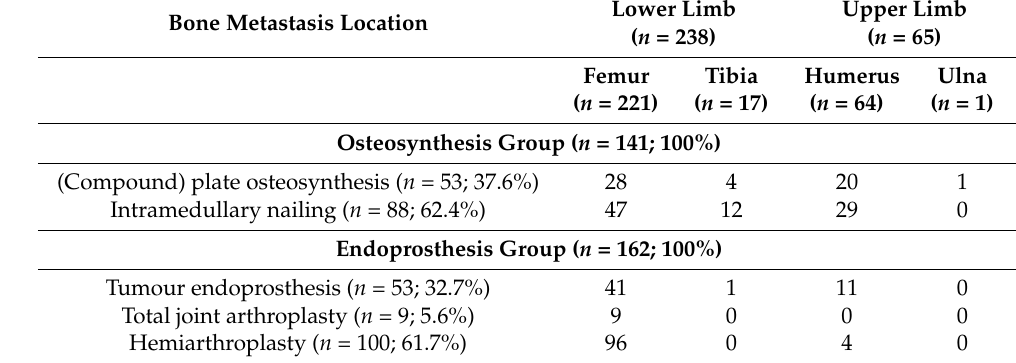
Table 1. Types of surgeries performed, separated by bone metastasis location.